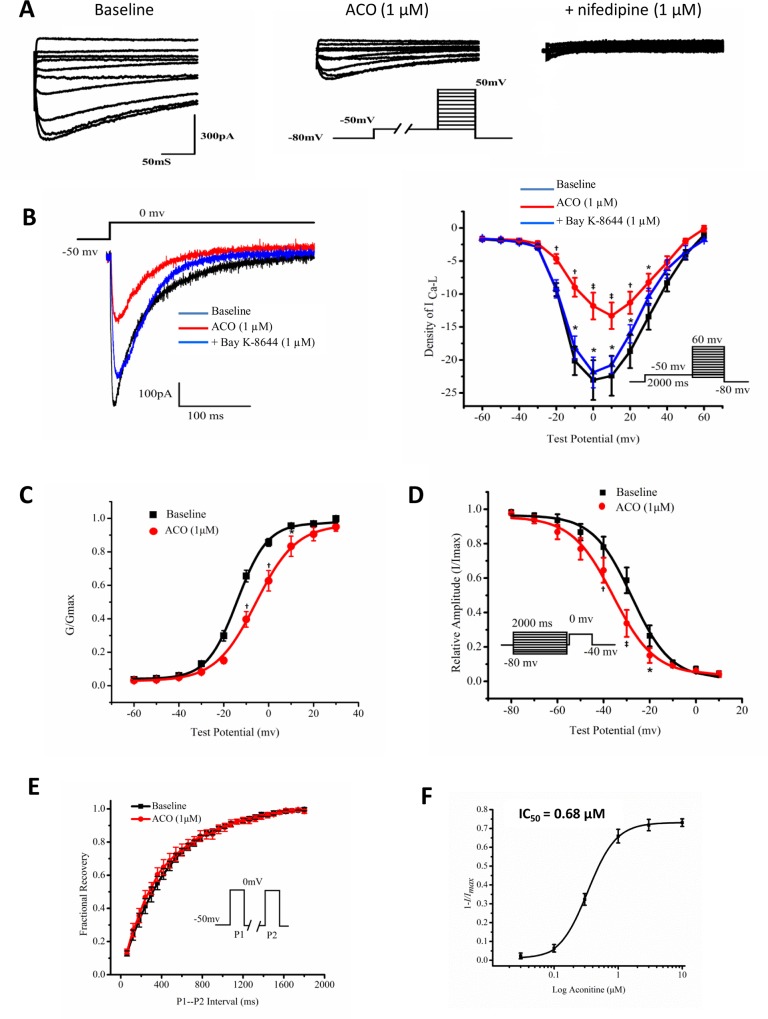
Effects of ACO on ICa,L in hiPSC-CMs.(A) Representative traces of the voltage-gated LTCC current ICa,L recorded from a hiPSC-CM at baseline followed by exposure of 1 μM ACO and addition of 1 μM nifedipine. (B) Representative traces and I-V curves recorded from hiPSC-CMs exposed to 1 μM ACO followed by 1 μM Bay K-8644. *p < 0.05, †p < 0.01, ‡
p < 0.001, ACO vs. baseline or Bay K-8644 vs ACO, n = 8. (C) The voltage-dependent activation curve of ICa,L recorded in hiPSC-CMs exposed to 1 μM of ACO. G/Gmax: normalized peak conductance. *p < 0.05, †p < 0.01, vs. baseline. n = 5. (D) The SS-inactivation curve of ICa,L. *p < 0.05, †p < 0.01, ‡
p < 0.001, vs. baseline. n = 5. (E) Recovery from inactivation of ICa,L. n = 5. Insert shows the 2-pulse protocol. (F) The IC50 of ACO on ICa,L (n = 8).